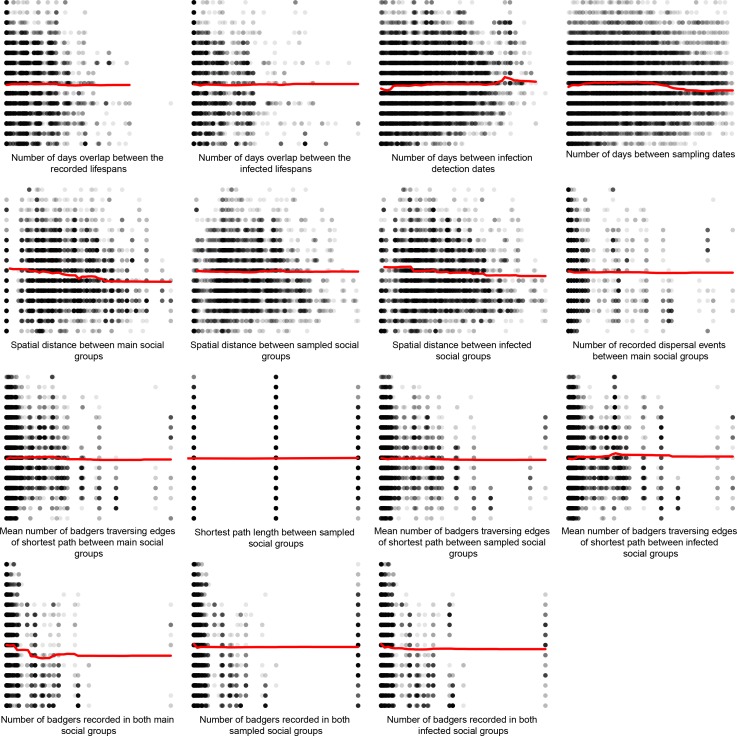
Partial dependence plots estimating the average marginal effect of each epidemiological metric fitted in the Random Forest regression models on the inter-badger-sequence genetic distance distribution.The Y axis in each sub-plot represents the genetic distance distribution of the number of the differences between the M. bovis genomes. The X axis of each plot corresponds to the range associated with the corresponding epidemiological metrics. The red line represents the average marginal effect on the predicted genetic distance for each value of the epidemiological metric. Metrics with low importance in the Random Forest models were removed (% Mean Squared Error change of < 0.5%).